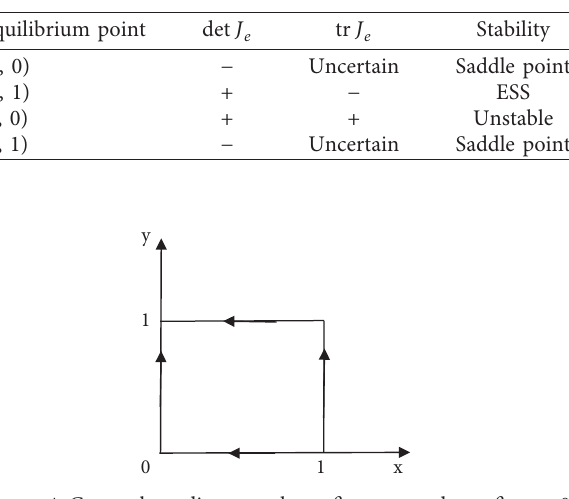
Table 3: Analysis of partial equilibrium table.